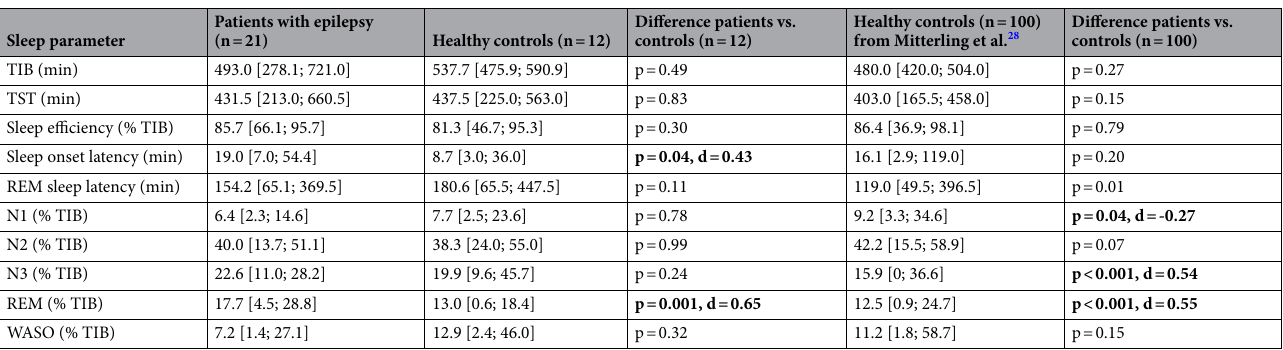
Table 2. Sleep macrostructure in patients with epilepsy (n = 21) compared to healthy controls (n = 12) from the current study and compared to a larger healthy control population (n = 100) from Mitterling et al. 28 . TIB time in bed, TST total sleep time, WASO wake after sleep onset. Significant values are in